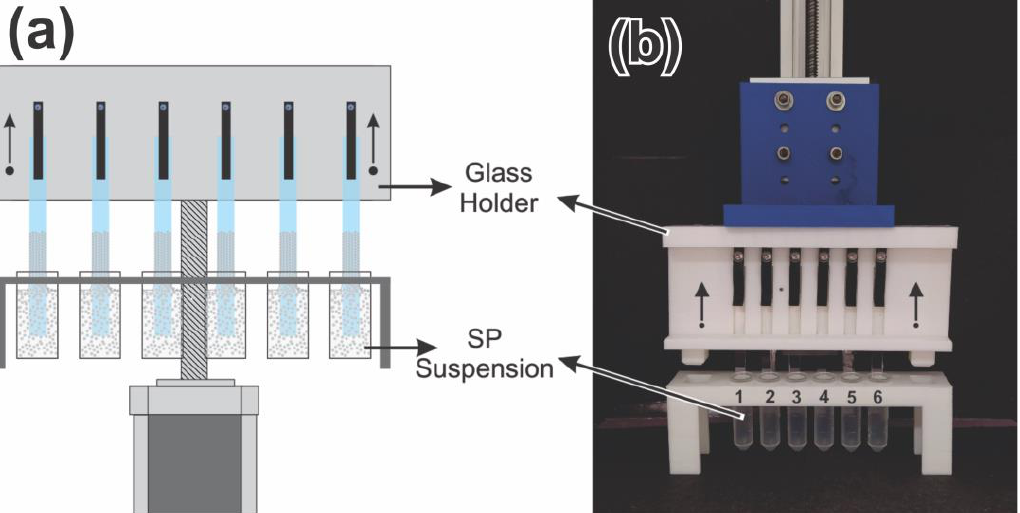
Figure 8. Schematic representation ( a ) and photograph ( b ) of experimental set-up employed for the reproducibility assays.